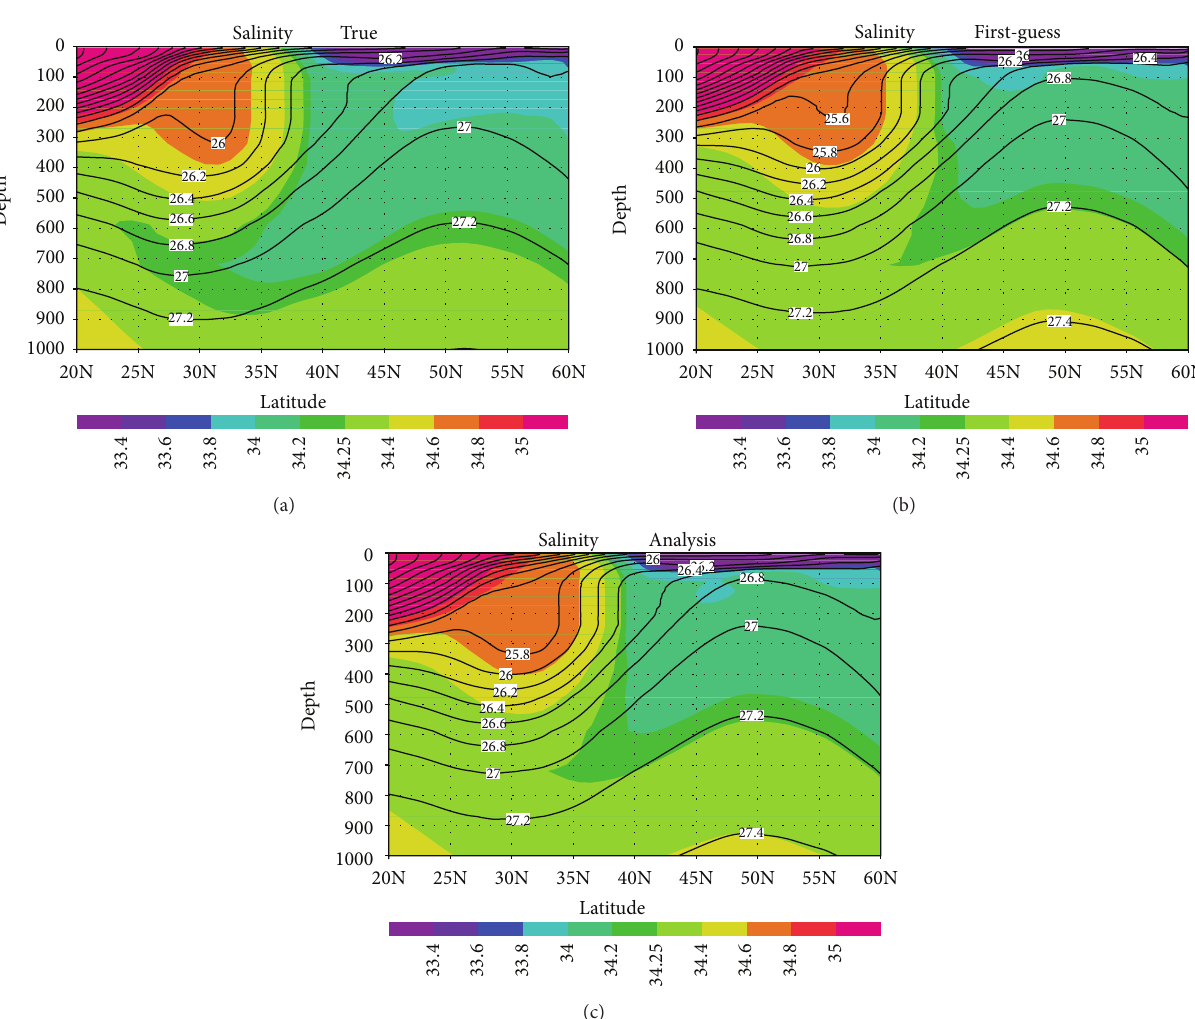
Figure 4: Mean salinity distribution (colors) and contours of potential density ( 𝜎𝜃 ) in a vertical cross section along 180 ∘ (gray line in Figure 1) averaged over 1995–2000: (a) true case, (b) first-guess case, and (c) analysis